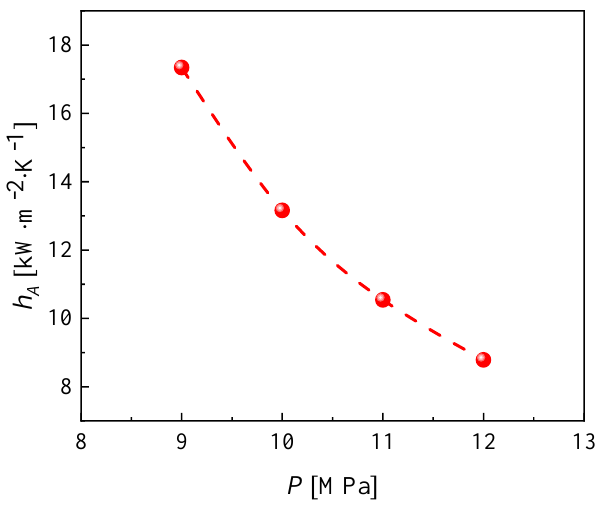
peak heat transfer coefficient of CO 2 reaches 27.5 kW · m − 2 · K − 1 at a cooling pressure of